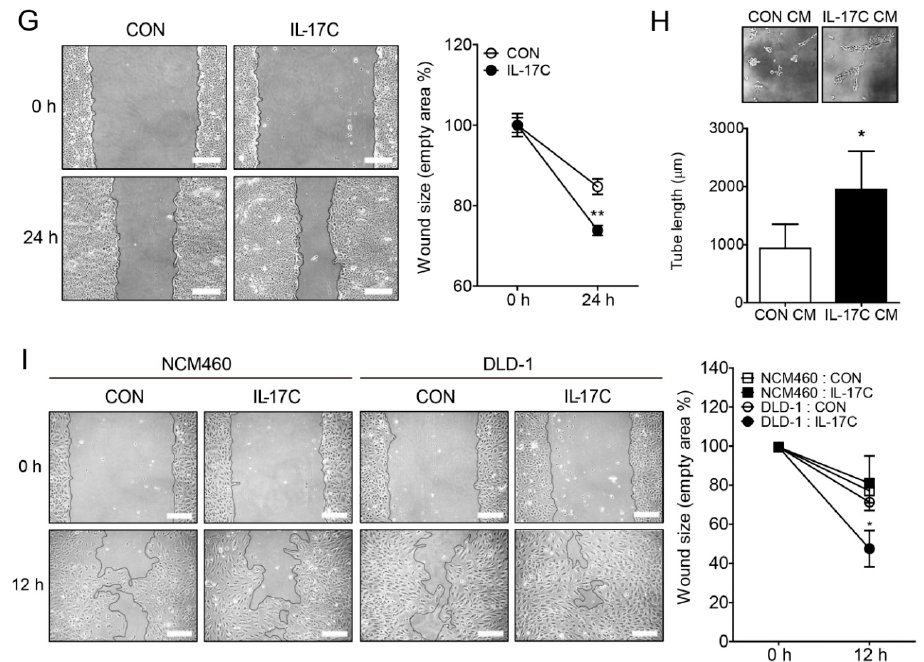
Figure 2. IL-17C has active functions in tumorigenesis. ( A ) Immunohistochemistry staining was used to detect IL-17C expression in human normal colon tissue and colorectal adenocarcinoma ( n = 3). Scale bar, 100 µ m. ( B , C ) Representative bands of RT-PCR and quantitative analyses of IL-17C in NCM460 and DLD-1 cells ( B ), and IL-17RA and IL-17RE in DLD-1 cells ( C ) are shown. GAPDH is used as the loading control. Error bars, SD ( n = 3). ** p < 0.01 vs. NCM460 ( B ); NS, not significant ( C ). ( D , E ) MTT ( D ) and colony formation ( E ) assays were performed using IL-17C (100 ng / mL, 24 h and 10 d, respectively) stimulated DLD-1 cells. Representative photographs are shown (( E ), top). Error bars, SD ( n = 6). NS, not significant. ( F ) An invasive assay was performed in DLD-1 cells with IL-17C (100 ng / mL, 24 h) stimulation. Error bars, SD ( n = 8). *** p < 0.001 vs. the control group. ( G ) A migration assay